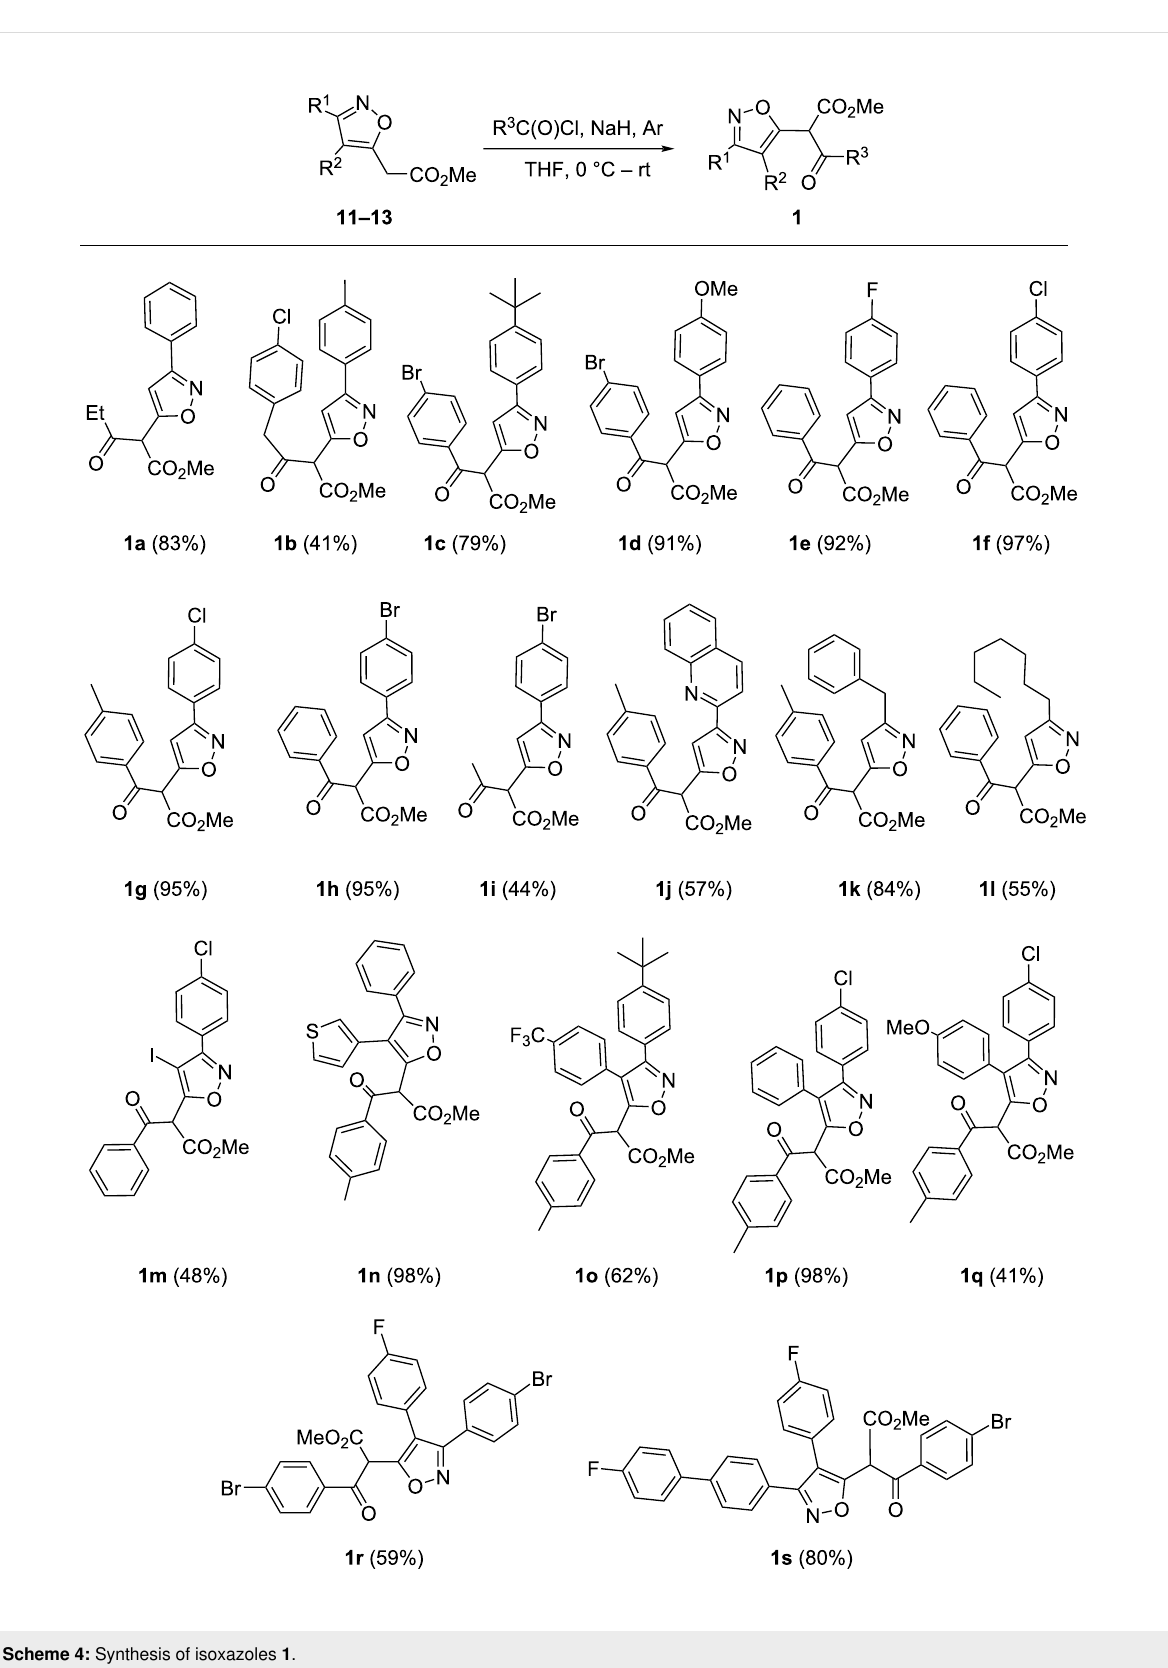
Scheme 4: Synthesis of isoxazoles 1